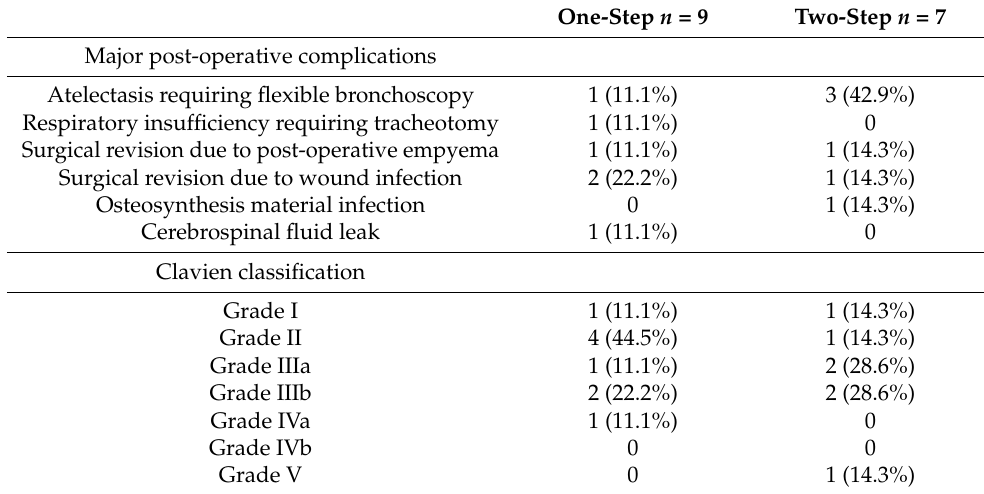
Table 3. Post-operative complications according to Clavien classification